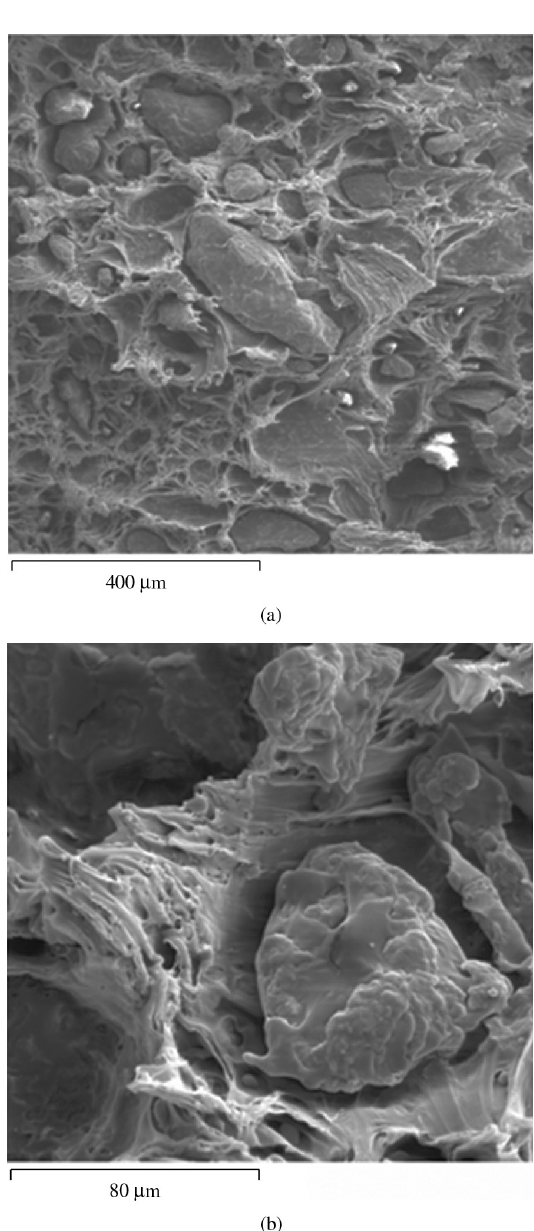
Figure 7. SEM micrographs of fractured surfaces of 80/10 LDPE/ PHB/10 CC